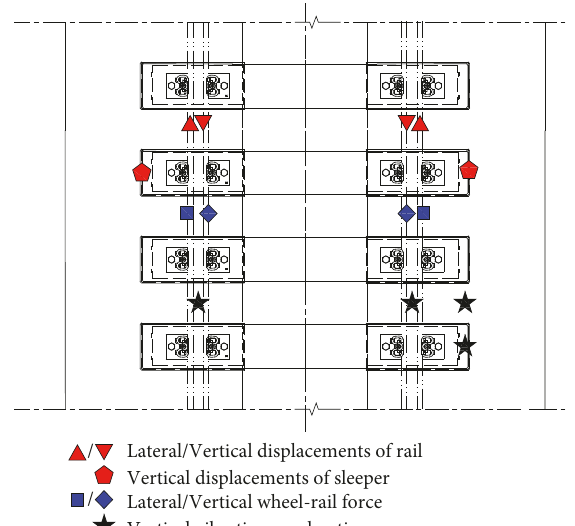
Figure 4: Arrangement plan of measurement points.